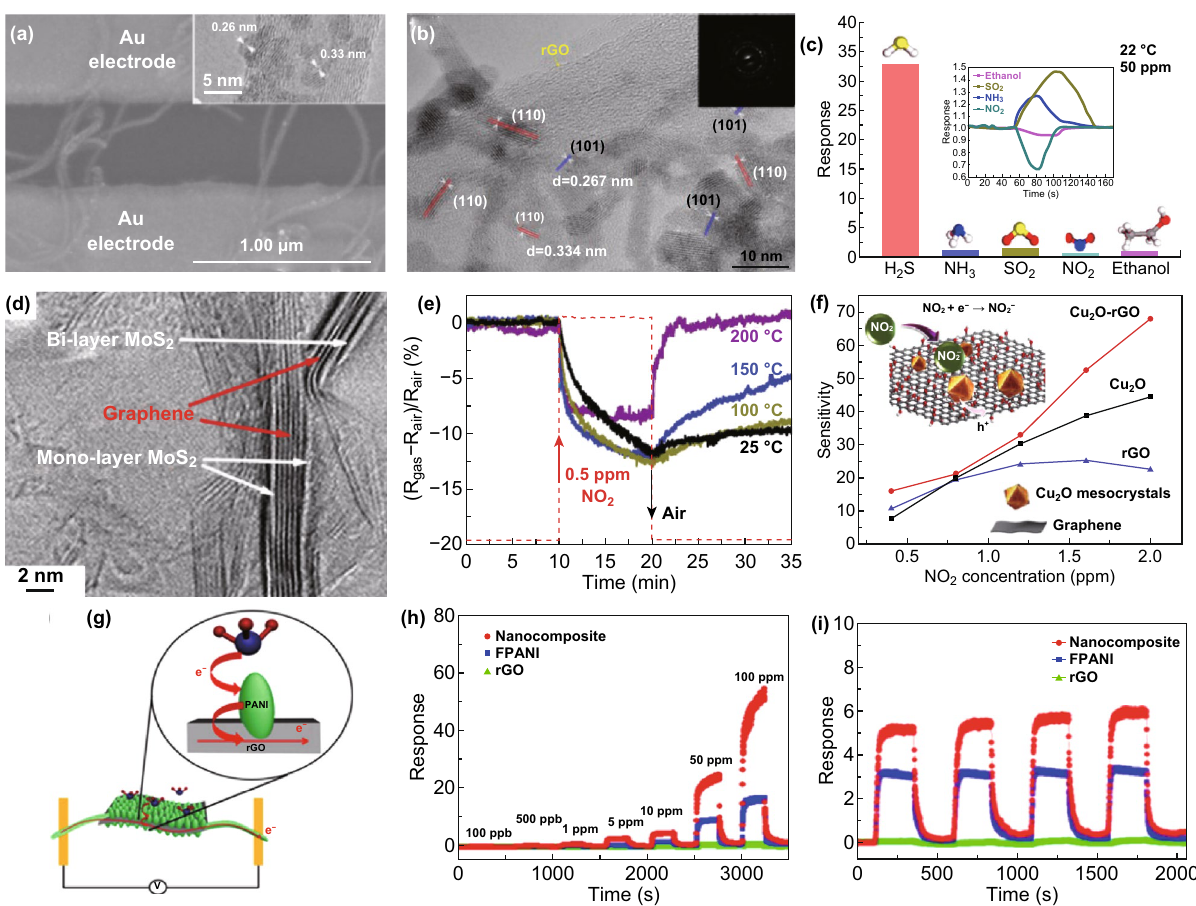
Fig. 6 a SEM image of the sensor after assembly of SnO 2 nanocrystals onto the MWCNTs (inset is the HRTEM image of a MWCNT uniformly coated with SnO 2 nanocrystals). Reproduced with permission [59]. Copyright 2009, Wiley–VCH. b TEM image of SnO 2 QDs/rGO hybrids; and c sensor responses to 50 ppm of different gas at RT. Reproduced with permission [109]. Copyright 2016, American Chemical Society. d Enlarged TEM image demonstrating the MoS 2 coating of the few-layer graphene scaffold. e Sensor response to 0.5 ppm NO 2 at different micro- heater temperatures, improving response and recovery time. Reproduced with permission [61]. Copyright 2016, Wiley–VCH. f Sensitivities of NO 2 sensor for the three devices (inset is a schema of the mechanism of NO 2 sensing of rGO-Cu 2 O). Reproduced with permission [62]. Copy- right 2012, American Chemical Society. g Schema of the sensing mechanism of rGO-PANI hybrids. h NH 3 responses of PANI, rGO and their hybrids at different concentrations. i Repeated NH 3 responses of PANI, rGO and their hybrids at 10 ppm. Reproduced with permission [63]. Copyright 2016, Royal Society